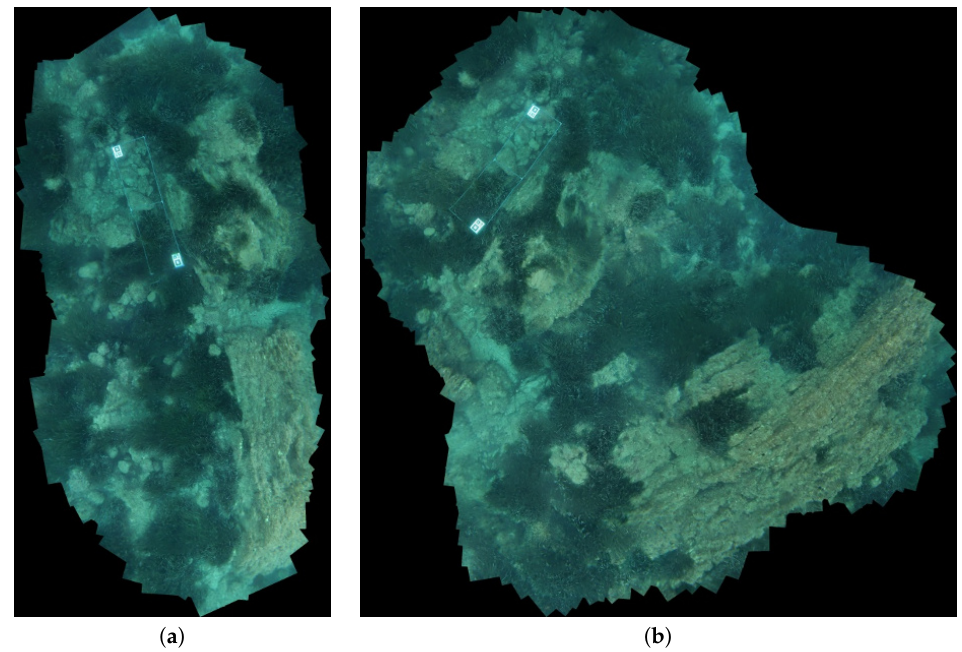
Figure 17. ( a ) Photo-mosaic of V 3 and ( b ) photo-mosaic of V